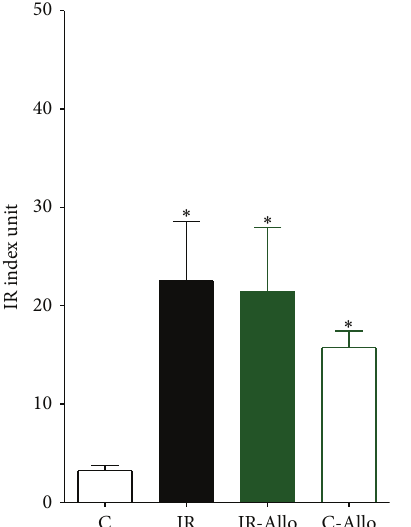
Figure 1: The effect of allopurinol (Allo) treatment on insulin resistance (IR)